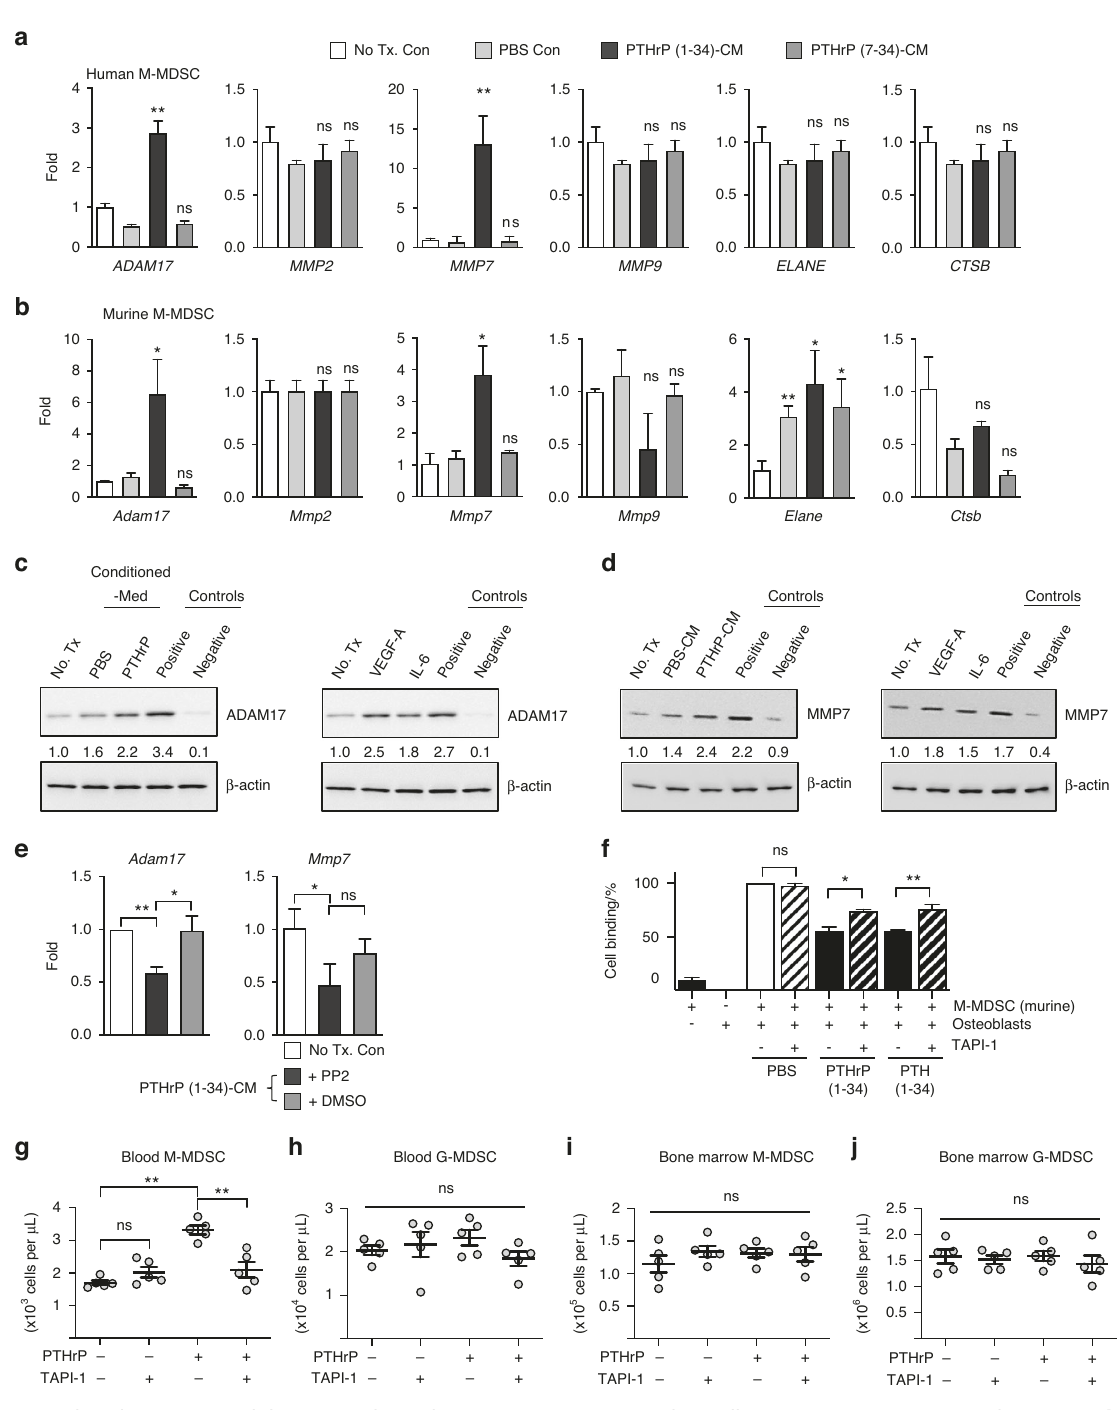
Fig. 8 PTHrP-induced M-MDSC mobilization is dependent on A Disintegrin And Metalloproteinase (ADAM) 17 and MMP7. a, b RT ‒ qPCR results of human or murine M-MDSCs stimulated for 2 h with PBS- or PTHrP-conditioned media from osteoblasts. No treatment (No Tx) or PBS treatment was used as a control. c, d Immunoblotting analysis showing that ADAM17 ( c ) and MMP7 ( d ) expression in murine M-MDSCs was increased by PTHrP-conditioned media compared with no treatment (No Tx) or PBS controls. Recombinant VEGF-A or IL6 also increased ADAM17 and MMP7 expression. Cell lysates of NIH3T3 or murine PBMCs were used as positive and negative controls for ADAM17 expression, respectively. Cell lysates from A549 and PC-3 cell lines were used as positive and negative controls for MMP7 expression, respectively. β -Actin was used as a loading control. Band intensities normalized to no treatment controls are indicated. e RT ‒ qPCR results showing that Adam17 and Mmp7 expression in murine M-MDSCs was suppressed by PP2, an SFK-speci fi c inhibitor. DMSO was used as a vehicle control. f In vitro cell binding assay with TAPI-1, an inhibitor of ADAM17 and MMPs. TAPI-1 treatment (50 μ mol·L − 1 ) reversed PTHrP(1-34)- or PTH(1-34)-induced MDSC release from osteoblasts. (g-j) TAPI-1 suppressed PTHrP(1-34)-induced M-MDSC mobilization in vivo. Female Balb/C mice were injected with rhPTHrP (1-34; 80 μ g·kg − 1 ) ± TAPI-1 (2 mg·kg − 1 , I.P.), followed by fl ow cytometric quanti fi cation of M- and G-MDSCs in blood and bone marrow. Dots represent individual samples, and horizontal lines represent the mean ± SEM. ** P < 0.01; ns nonsigni fi cant; Mann ‒ Whitney U test. Bar graph data ( a, b, e and f ) are the mean ± SEM ( n = 3 per group). n.s. nonsigni fi cant; * P < 0.05; ** P < 0.01. One-way ANOVA with multiple group